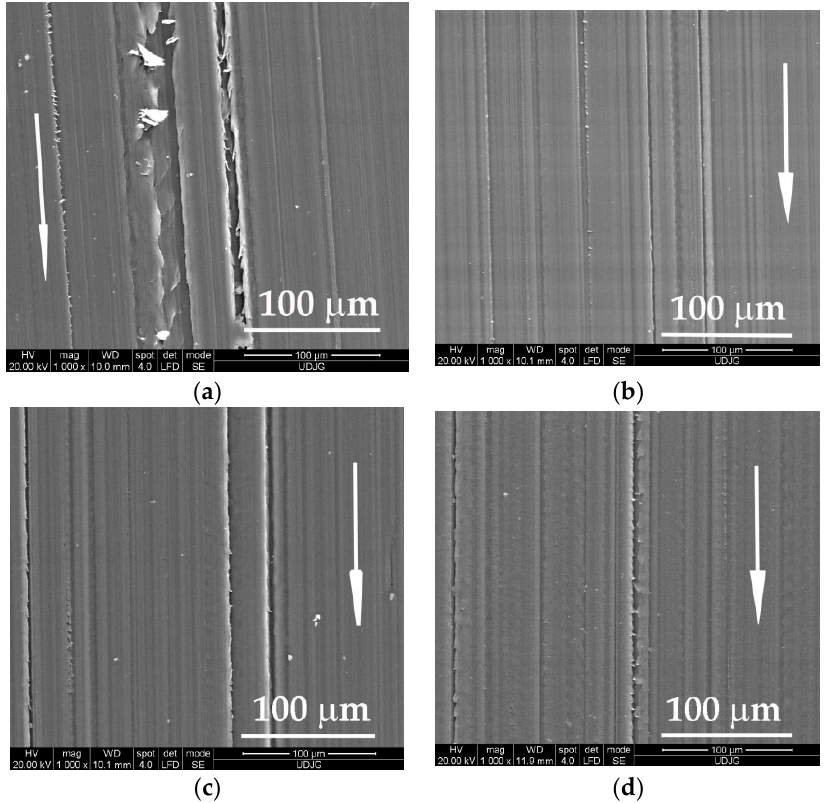
Figure 4. Appearance of worn surfaces for the block made of PBT, L = 5000 m: ( a ) F = 1 N, v = 0.25 m/s; ( b ) F = 1 N, v = 0.75 m/s; ( c ) F = 5 N, v = 0.25 m/s; ( d ) F = 5 N, v = 0.75 m/s.